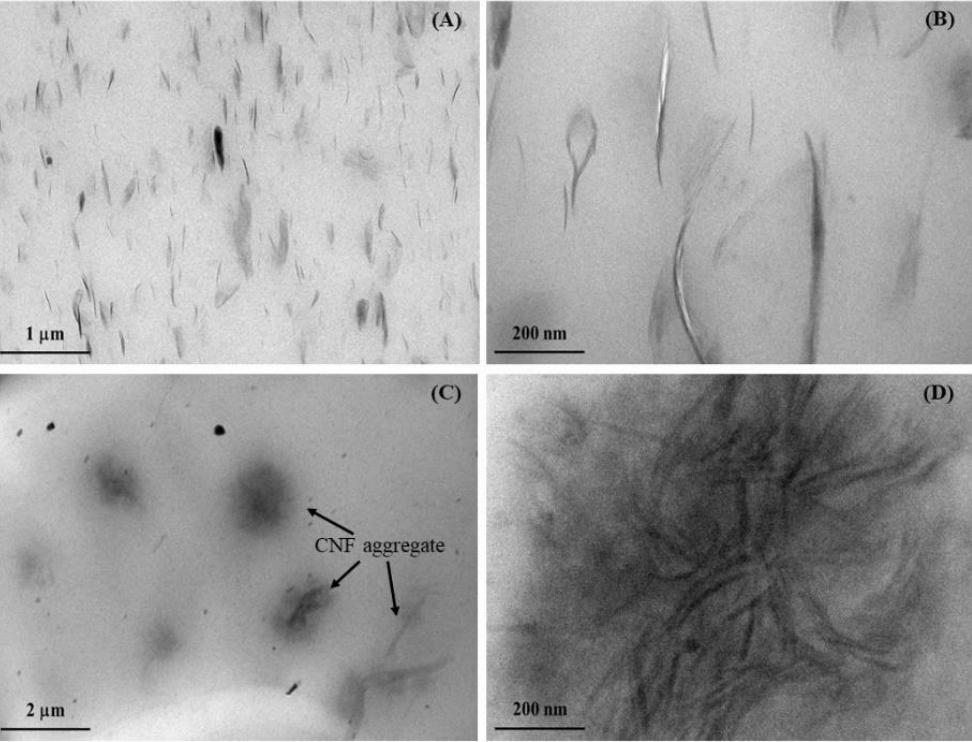
Figure 2. TEM images of ( A – B ) NC/NR and ( C – D ) CNF/NR taken at low magnification ( left ) and high magnification ( right ). Table 2. Dimension of dispersed NC in NC/NR and CNF aggregates in CNF/NR Samples